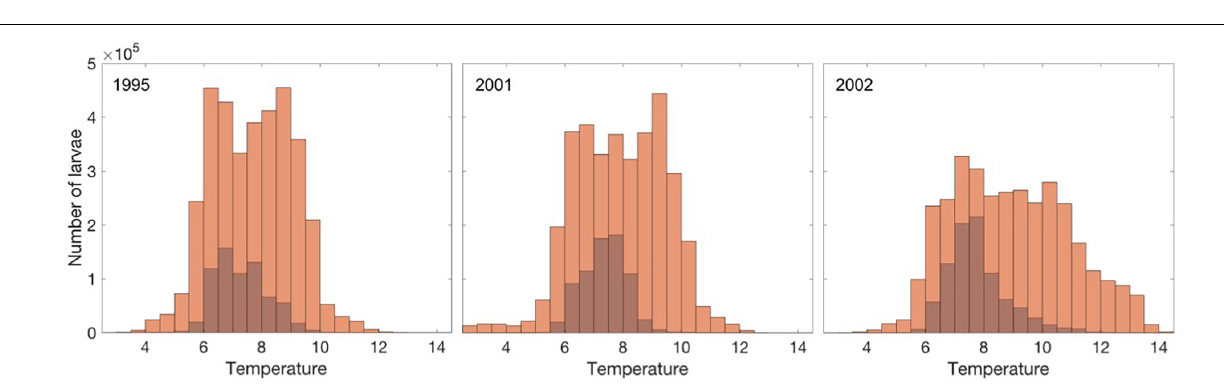
FIGURE 8 | Ambient temperature for individuals growing according to their temperature potential (light brown) and when limited by prey (dark brown) for the year 1995, 2001, and